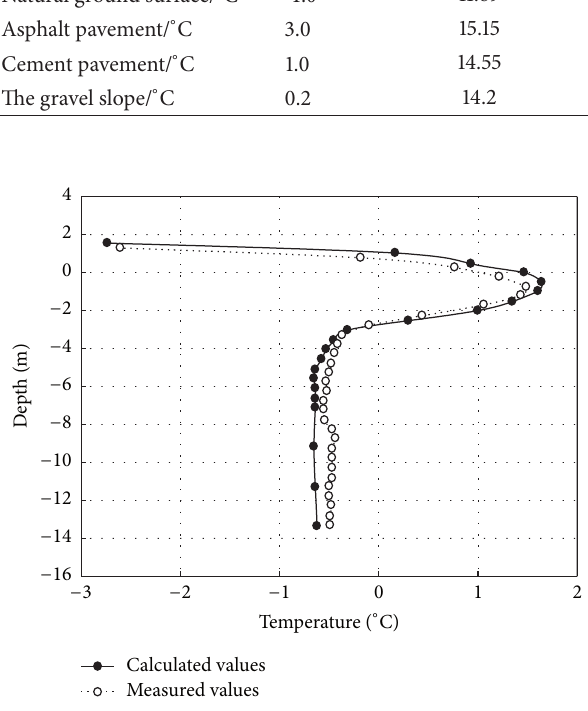
Figure 4: Measured and calculated temperature values at the maximum thawed depth of embankment center (1 year after the construction of cement concrete pavement).